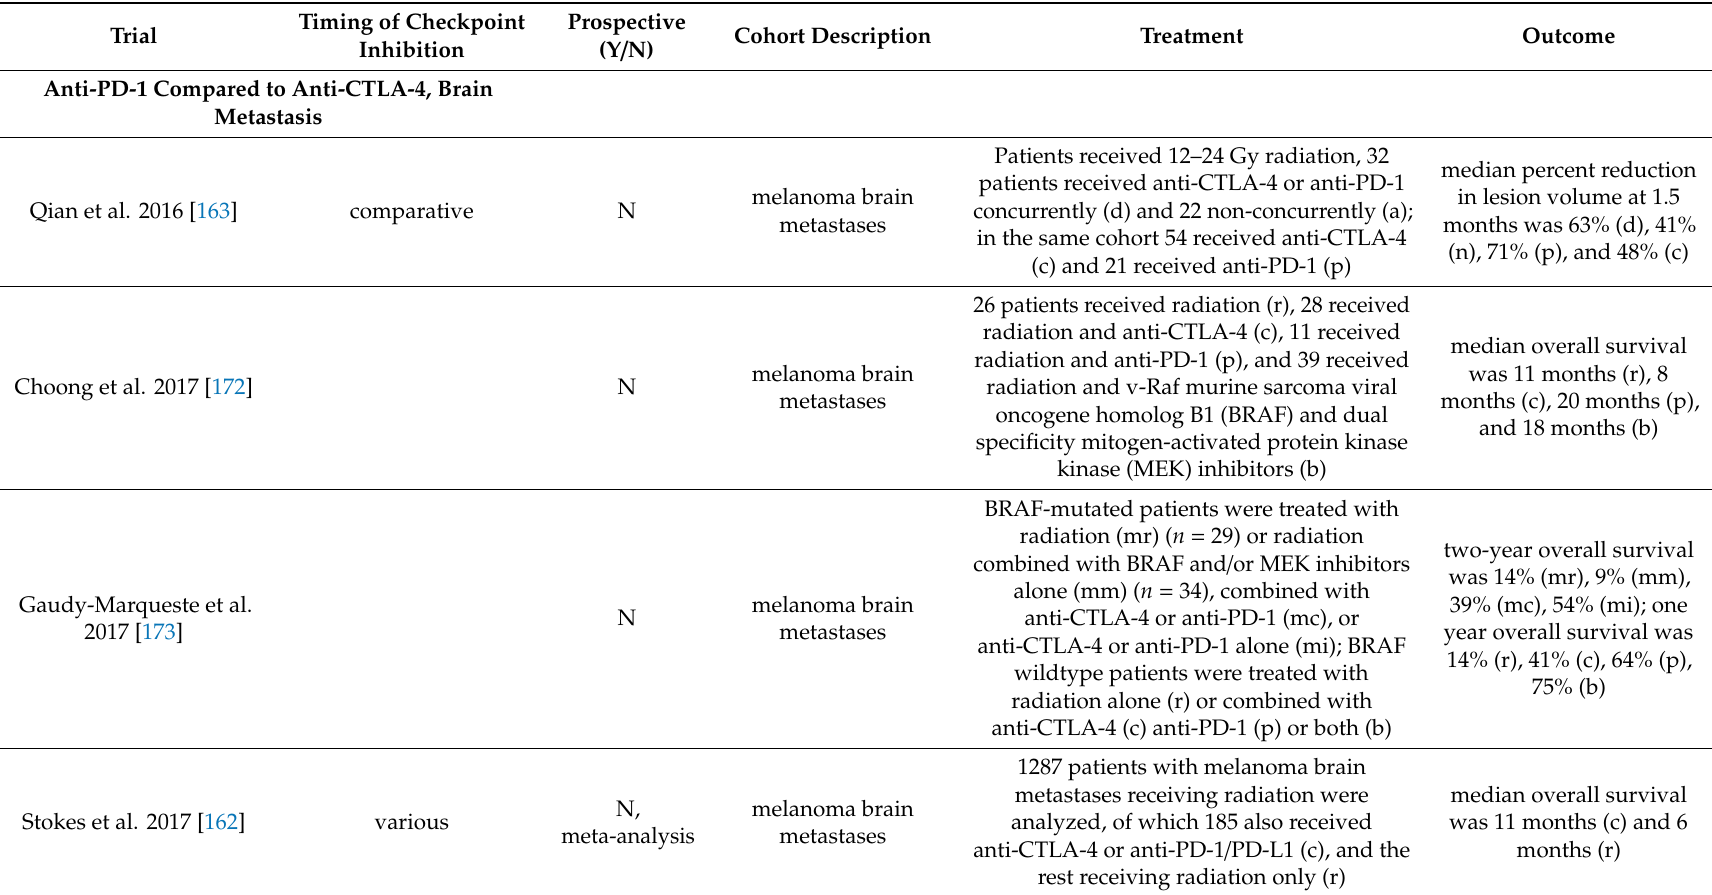
Table 4. Overview of clinical trials concerning comparison of anti-PD-1 and anti-CTLA-4 treatments in combination with radiotherapy in various cranial metastatic settings. Clinical trials are sorted primarily by cancer and treatment setting, secondary criteria being chronological. Short descriptions of patient collective, treatment, and outcome are